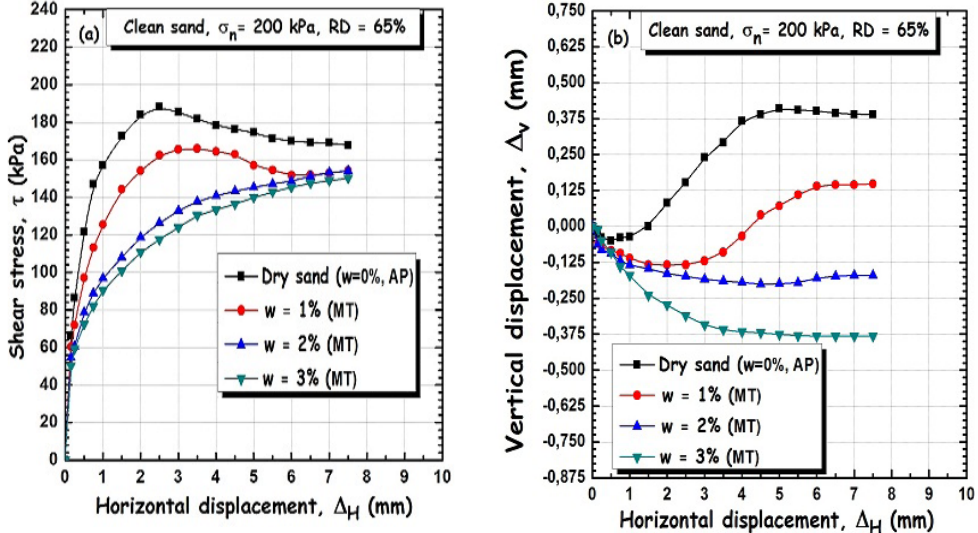
= 200 kPa): (a) variation of the shear strength n